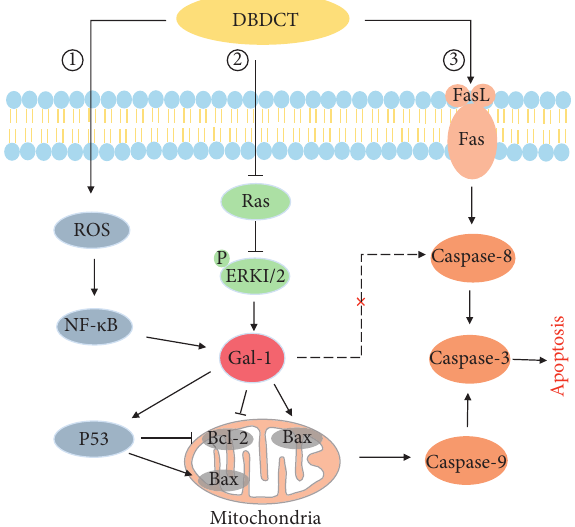
Figure 11: Schematic representation of possible mechanisms of DBDCT-induced apoptosis in HL7702 liver cells. ①② Gal-1-de- pendent mitochondria pathway. ③ DBDCT-regulated directly death receptor pathway which was not through Gal-1-dependent way ( ⟶ activation, ⊥